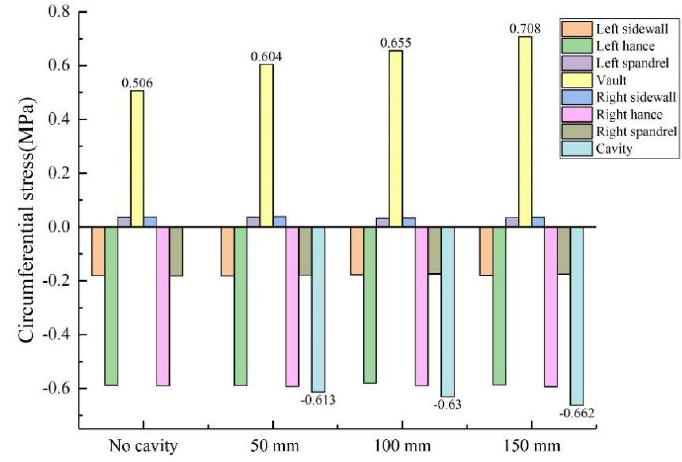
Figure 14. Variation of circumferential stress with vault void length.